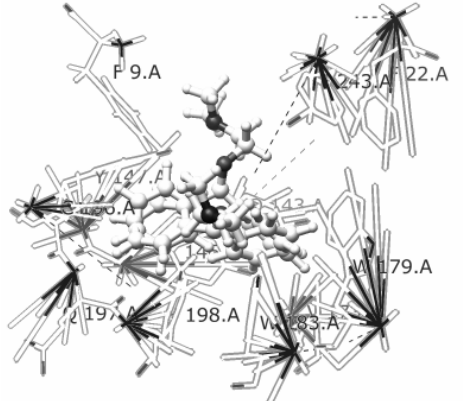
Figure 4. The close overlapping shown by the docked structure of diphenhydramine with its crystal structure with the r.m.s value